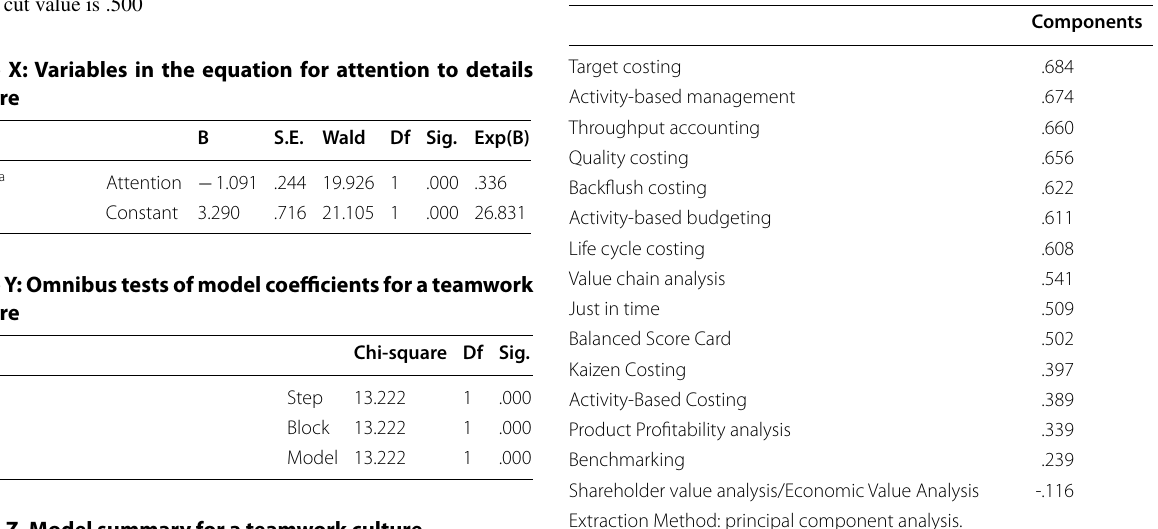
Table Z. Model summary for a teamwork culture